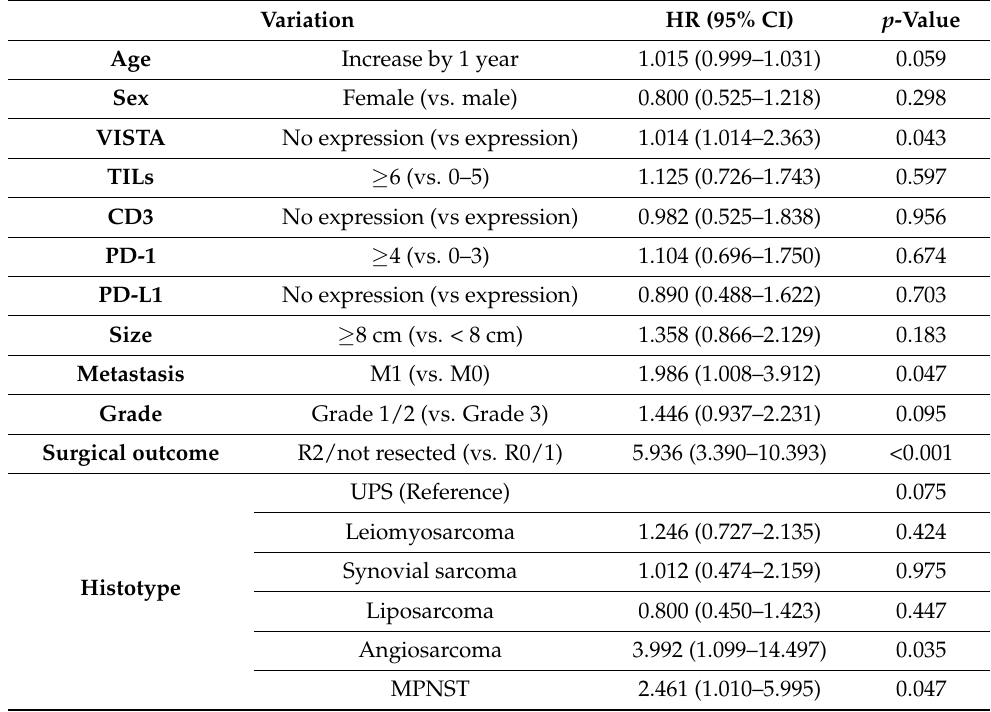
Figure 2. Univariate survival analysis depicted as Kaplan–Meier curves stratified according to VISTA expression. Table 4. Multivariate survival analysis using a Cox regression model. TILs, tumour-infiltrating lymphocytes; UPS: undifferentiated pleomorphic sarcoma; MPNST: malignant peripheral nerve sheath tumour.